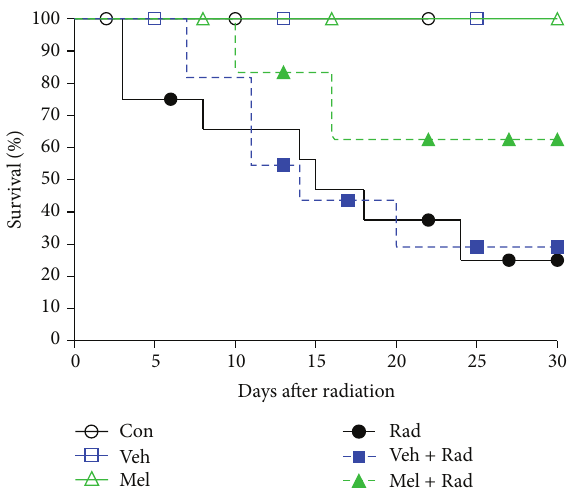
Figure 1: Survival of whole body irradiated rats pretreated with melatonin. Con: Control group, Veh: Vehicle only group, Mel: Melatonin only group, Rad: Radiation only group, Veh + Rad: Treated with vehicle and exposed to 10Gy radiation, and Mel + Rad: Treated with 100mg/kg melatonin before exposure to 10Gy radiation.